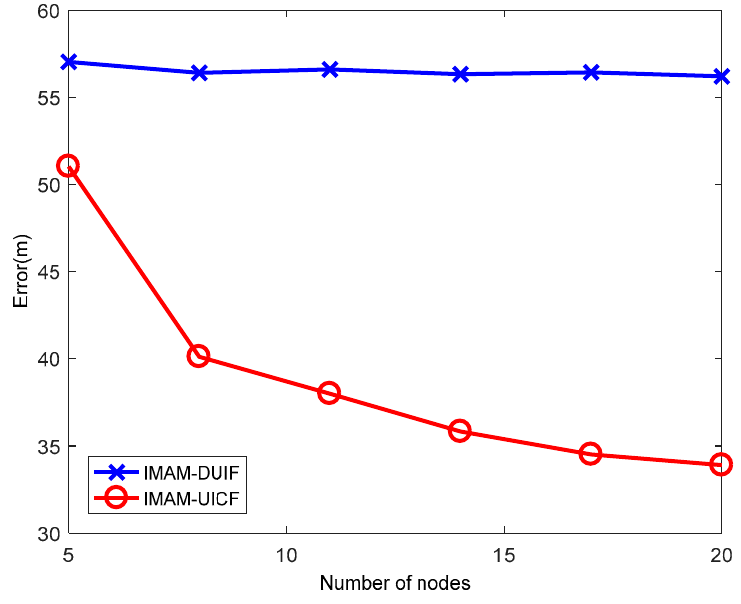
Figure 12. The velocity ARMSE of the two algorithms with varying number of sensors.